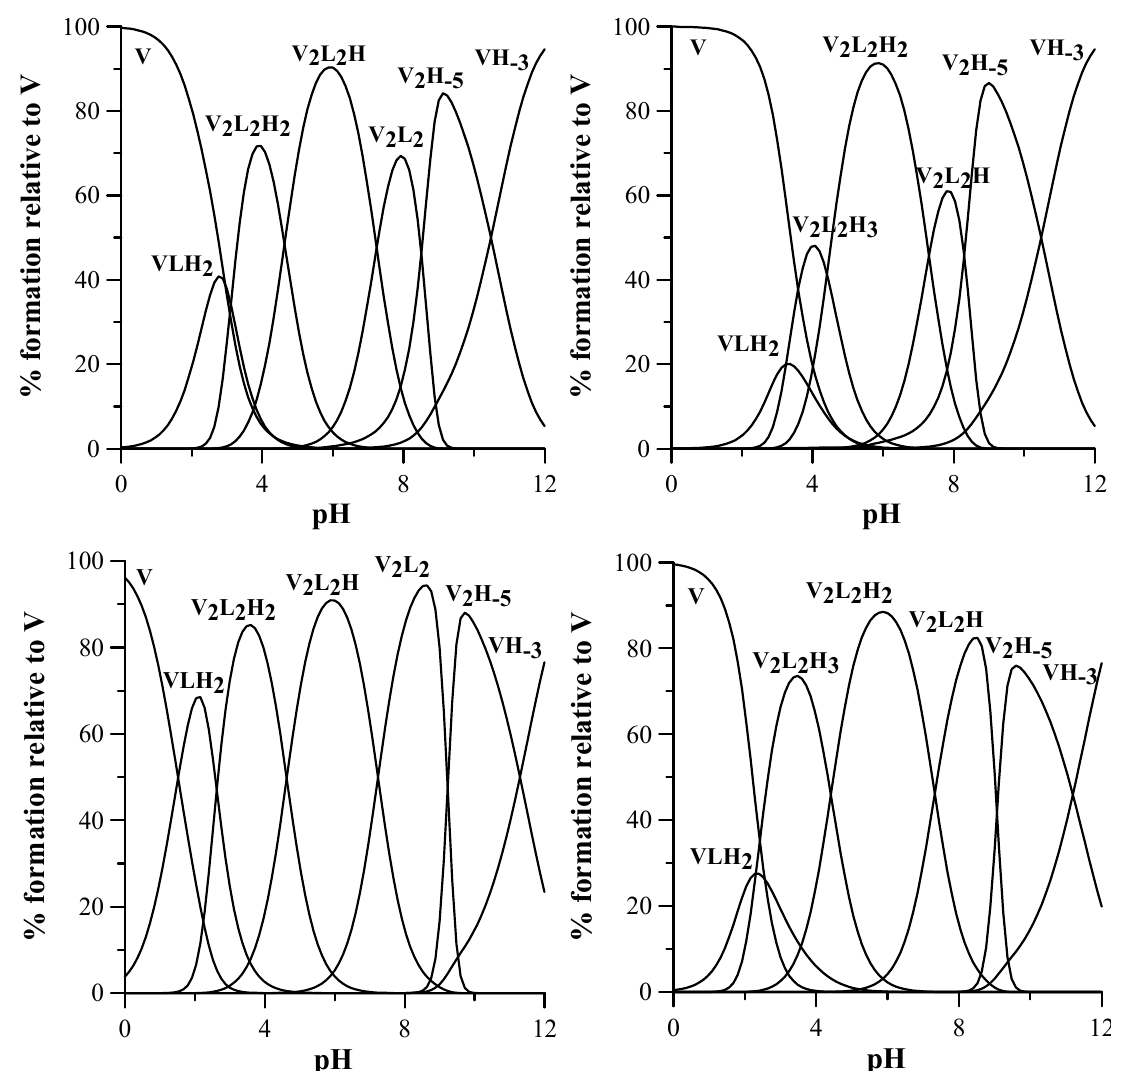
Figure 2. Speciation plots of V IV O 2+ -ligand systems (L4 on the left and L9 on the right), calculated with Hyss program [55]. Top: conditions of spectrophotometric titrations, 1:1 V IV O 2+ :ligand molar ratio at ligand concentration 3 × 10 − 4 M. Bottom: conditions of EPR measurements 1:2 V IV O 2+ :ligand molar ratio at ligand concentration 4 mM. V stands for V IV O 2+ , and L for L4 or L9; charges are omitted for simplicity.